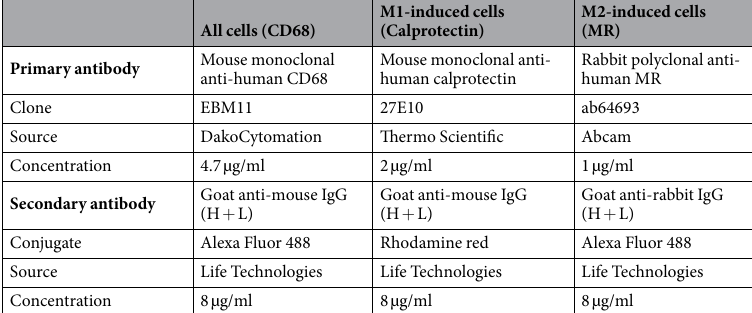
Table 1. Primary and secondary antibodies used for